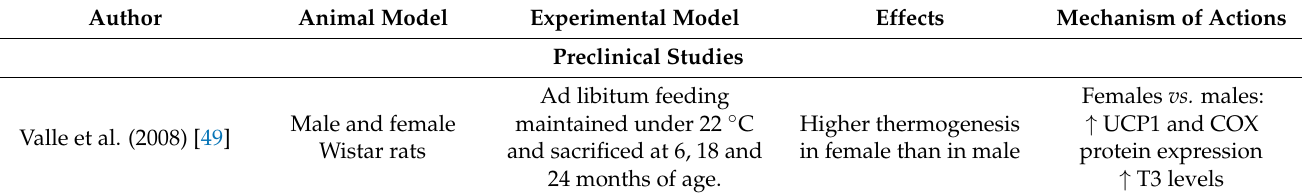
Table 3. Sexual dimorphism in the effect of age on BAT thermogenesis in preclinical and clinical